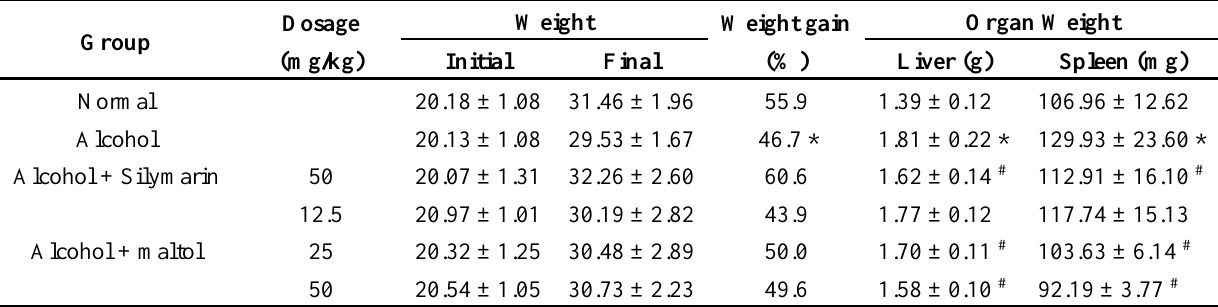
Table 1. Effects of maltol on body weight and organ weight in